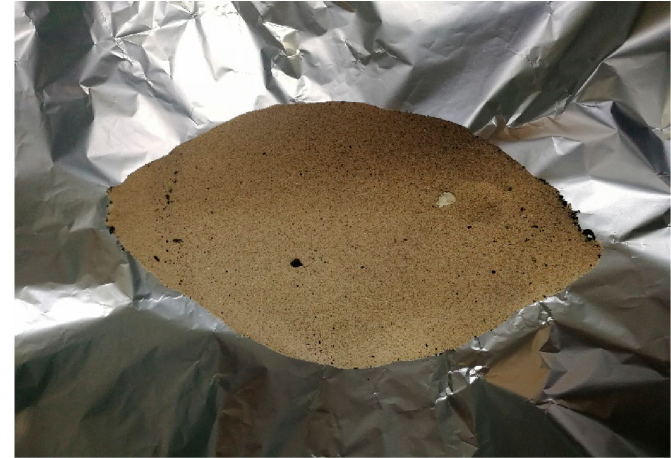
Figure 10. Post-test sand.